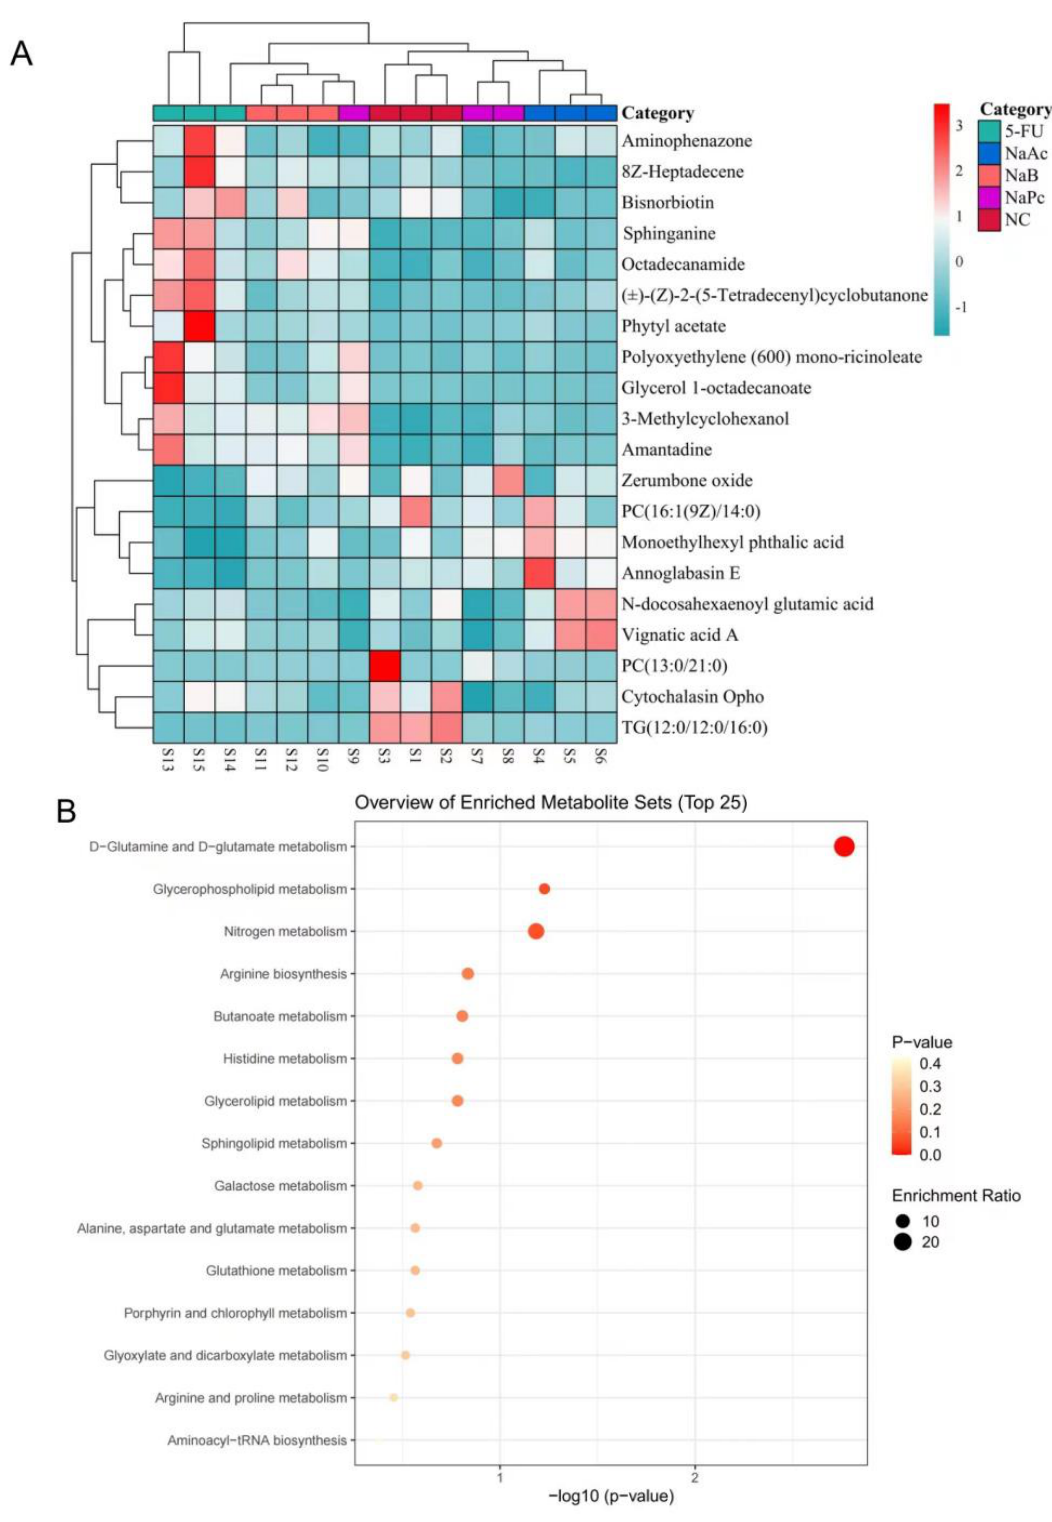
Figure 7. The heat maps of differential metabolites and the main metabolic pathway impact analysis. ( A ): heat maps of differential metabolites from cells. Rows: metabolites; Columns: samples. On the top is the cluster of samples, and on the left is the cluster of metabolites. Red means the metabolites were expressed at a higher level, and blue means the metabolites were expressed at a lower level. ( B ): the main metabolic pathway impact analysis. The smaller the p -value, the more significant the enrichment. The magnitude of the enrichment factor indicates the reliability of